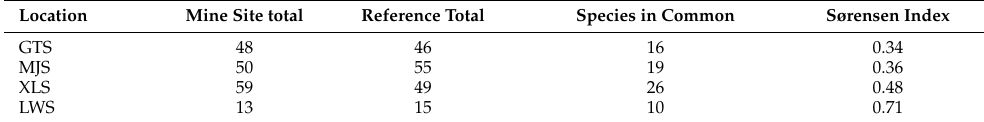
Table 4. Species similarity results among site pairs at each location (mine and adjacent reference sites). Location